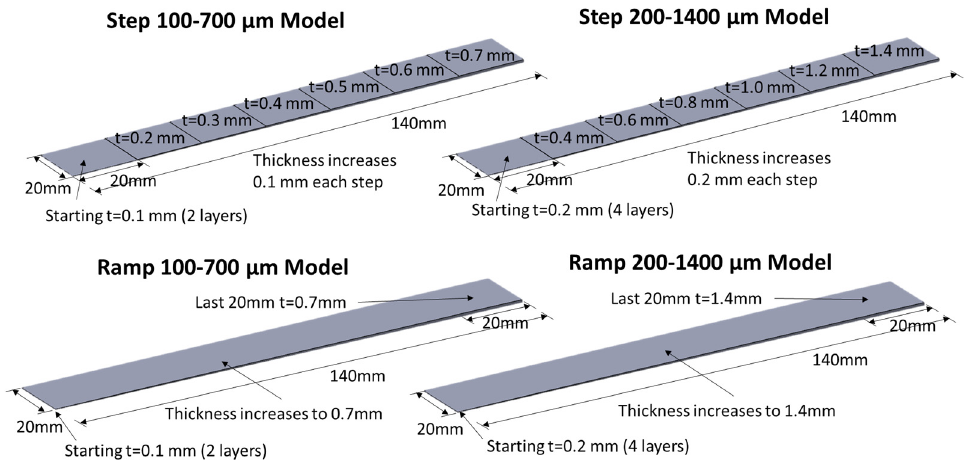
Figure 2. Meso-scale experiment specimen design illustrating the dimensions of the thin and thick CAD models of step and ramp.